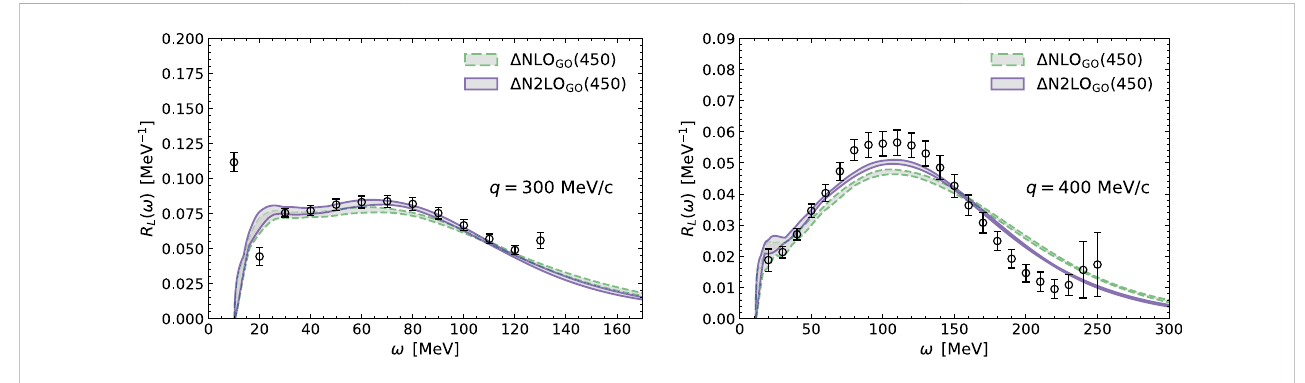
FIGURE 6 Longitudinal response functions of 40 Ca for the momentum transfer q =300 MeV/c (left panel) and q =400 MeV/c (right panel). Two orders of the chiral expansion of the nuclear Hamiltonian are shown. The uncertainty band originates from the inversion procedure of the LITs. The experimental data are taken from Ref.